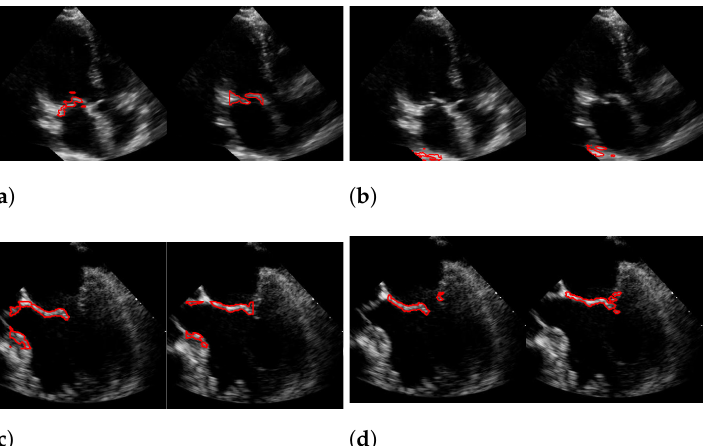
Figure 18. Segmentation in the cases of the largest differences between the f1-scores of our approach (segmentation with windowing) ( a , c ) and the one of Corinzia et al. ( b , d ). The results in ( a , b ) belong to the red rightmost bar of Figure 15, the results in ( c , d ) belong to the leftmost